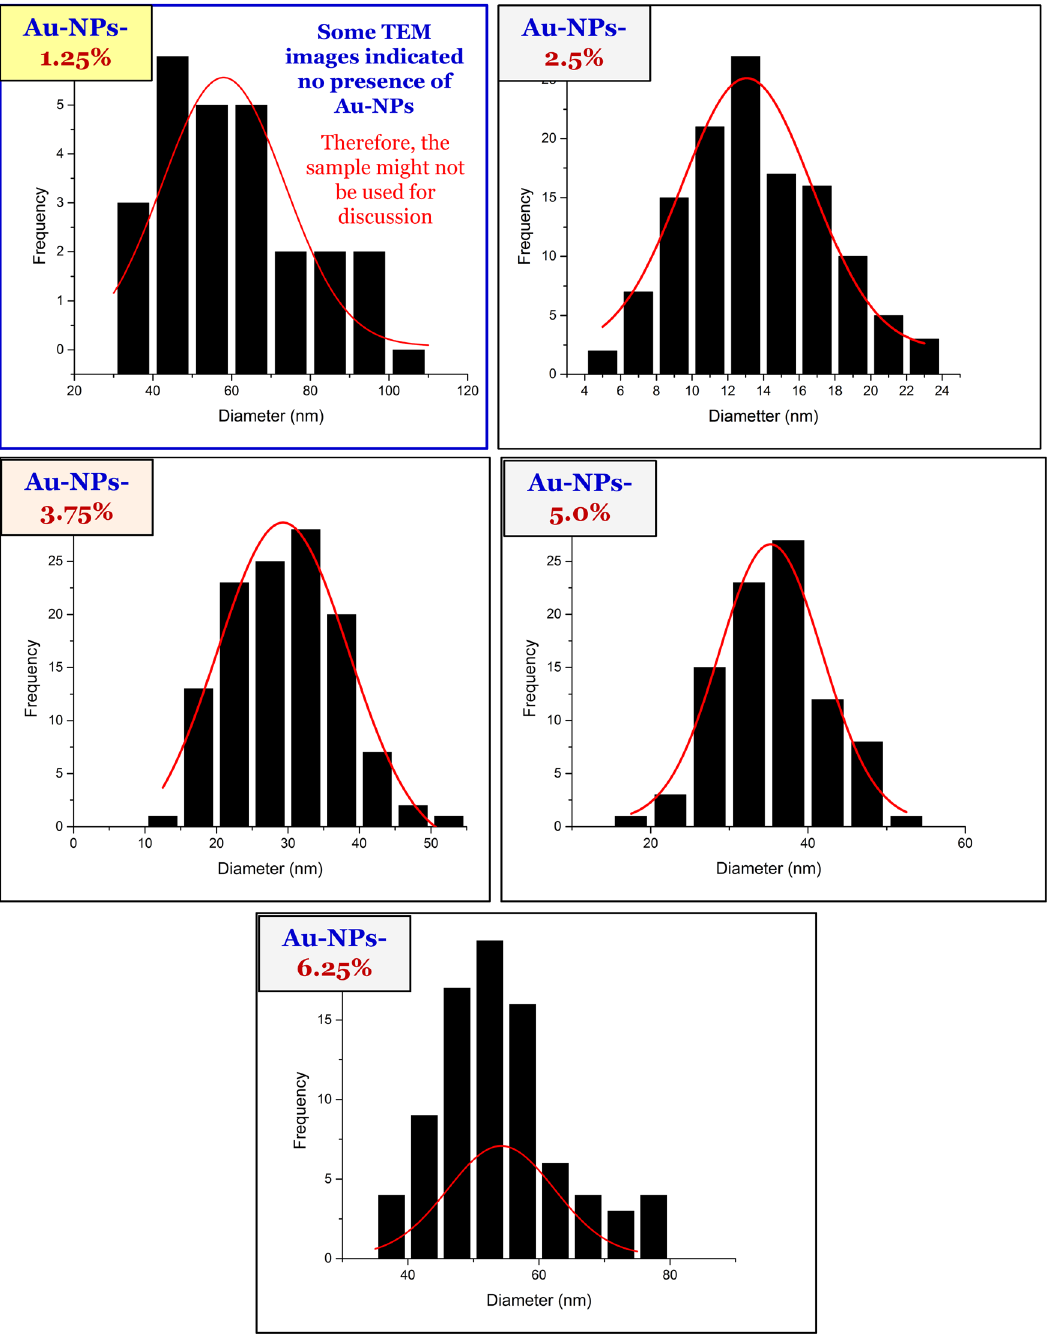
Figure A1: Particles size distribution of Au - NPs prepared at di ff erent ratios of the extract